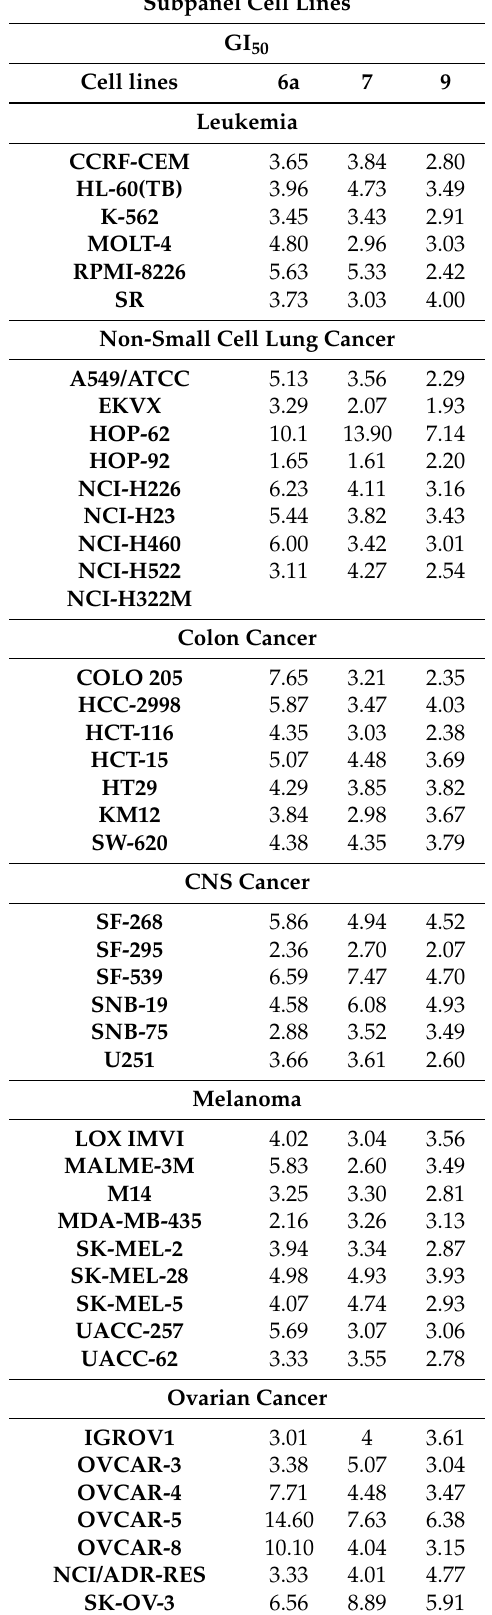
Table 2. GI 50 ( µ M) of five-dose screening results of compounds 6a , 7 and 9 . Subpanel Cell